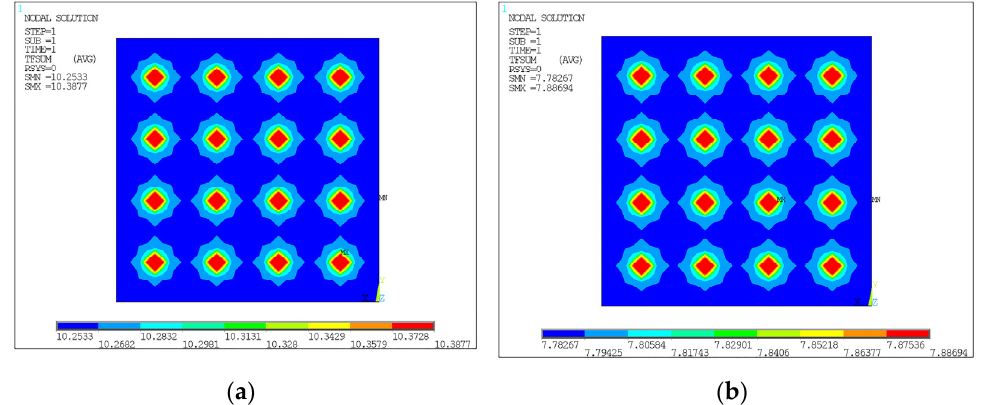
Figure 14. Heat flux: ( a ) S-50XPS; ( b ) S-80XPS. Note: MX, MN are abbreviations for maximum and minimum, respectively; X, Y, and Z are the directions of the coordinates.